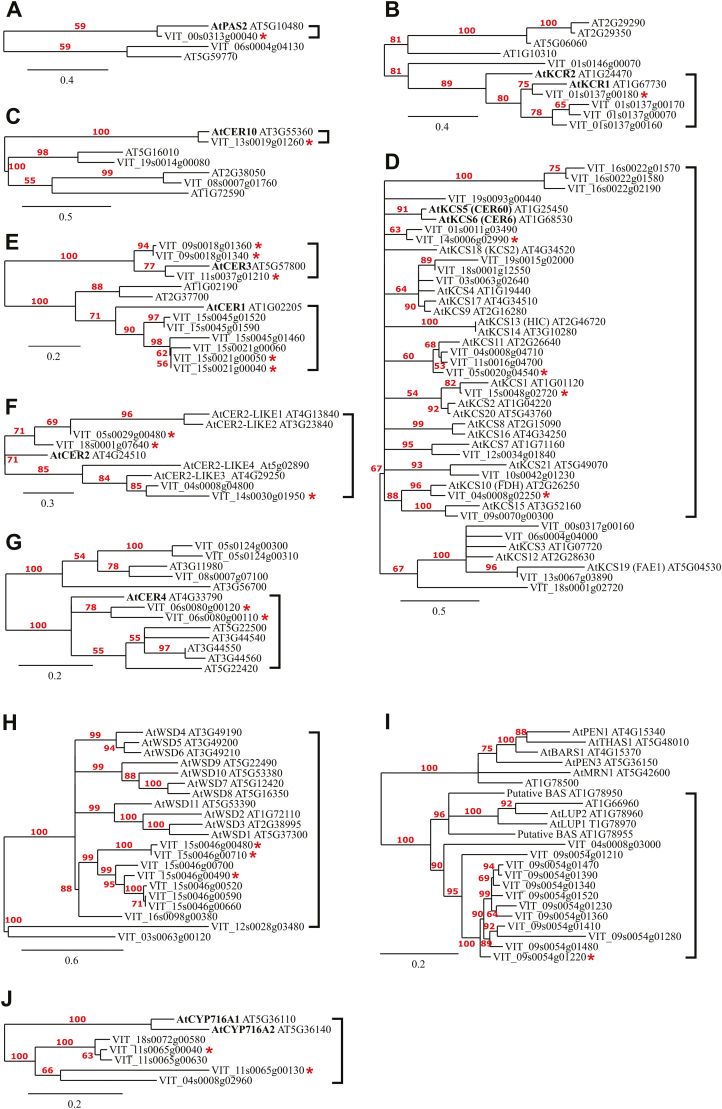
Protein sequence phylogenetic relationships of putative grapevine (Vitis vinifera L.) homologs of Arabidopsis biosynthetic genes involved in cuticular aliphatic wax biosynthesis. PAS2 (A), KCR1 (B), CER10 (C), KCS6 (D), and CER2 (F) are involved in fatty acid elongation. CER3 and CER1 (E) are part of the alkane-forming branch, and CER4 (G) and WSD1 (H) are part of the alcohol-forming branch. BAS (I) and CYP716A (J) are part of the oleanolic acid biosynthetic pathway. Numbers represent bootstrap values (100 bootstrap replicates), with branches of values <50 being collapsed together. Bold brackets denote clades that contain the characterized Arabidopsis sequences (in bold) involved in cuticular wax synthesis, and genes that are most closely related and are the likeliest functionally related homologs. Asterisks denote genes selected for study in the water deficit experiment. Scale bars are shown in each panel.